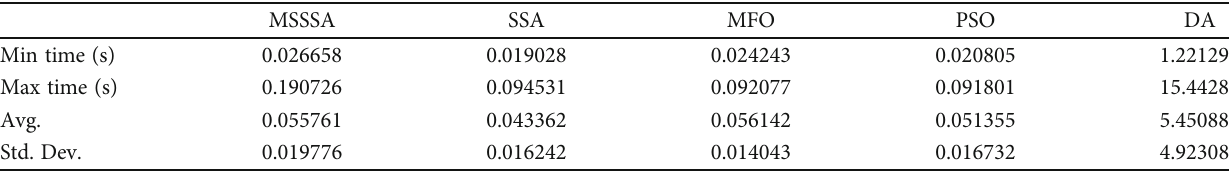
Figure 9: (a) MSSSA current distribution. (b) SSA current distribution. (c) MFO current distribution. (d) PSO current distribution. (e) DA current distribution. Table 5: HESS optimization speed test